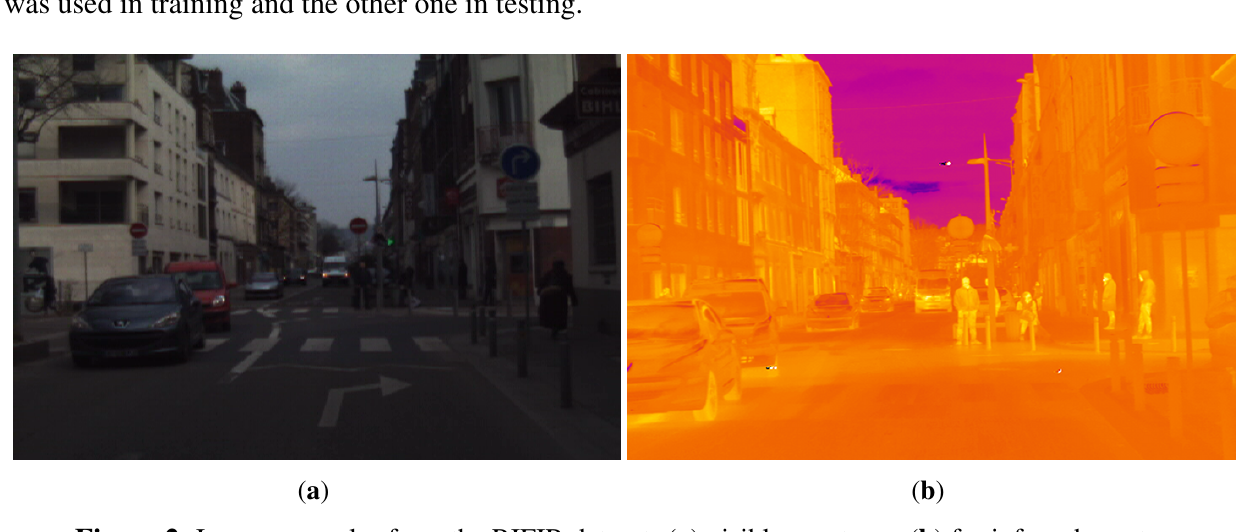
Figure 2. Image examples from the RIFIR dataset: ( a ) visible spectrum; ( b ) far-infrared